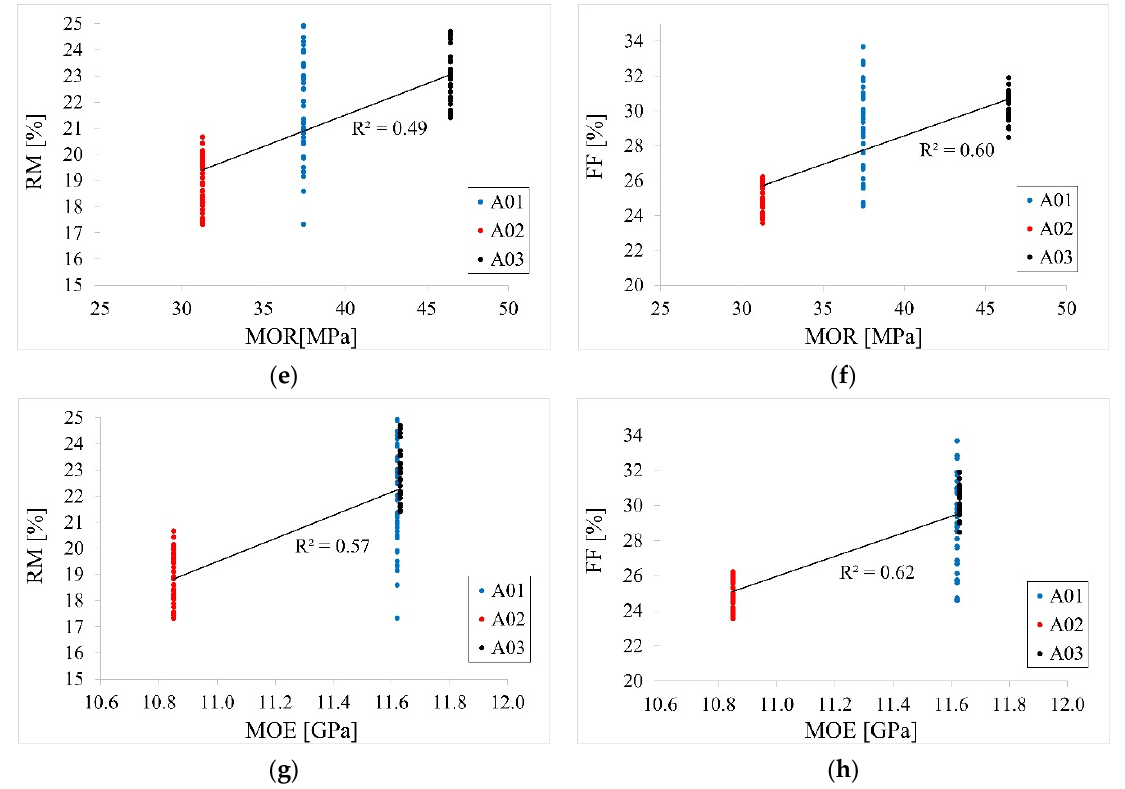
Figure 11. Correlation plots of Resistance Measure and Feed Force results ( a ) correlation between RM and FF, ( b ) correlation between RM and FF for beams separately, ( c ) correlation between RM and density, ( d ) correlation between FF and density, ( e ) correlation between RM and MOR obtained from structural size beam bending test, ( f ) correlation between FF and MOR obtained from structural size beam bending test, ( g ) correlation between RM and MOE obtained from structural size beam bending test, ( h ) correlation between FF and MOE obtained from structural size beam bending test.